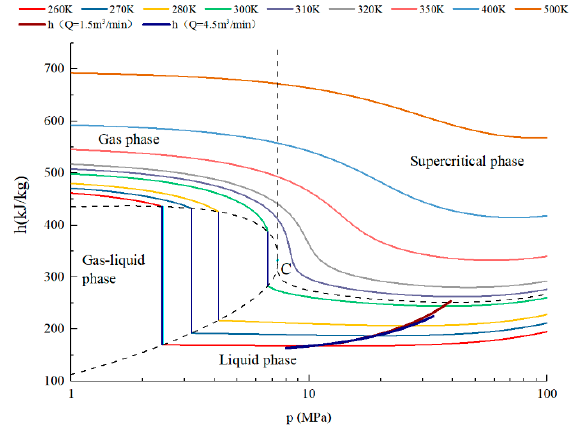
Figure 8. CO 2 phase distribution in the wellbore.